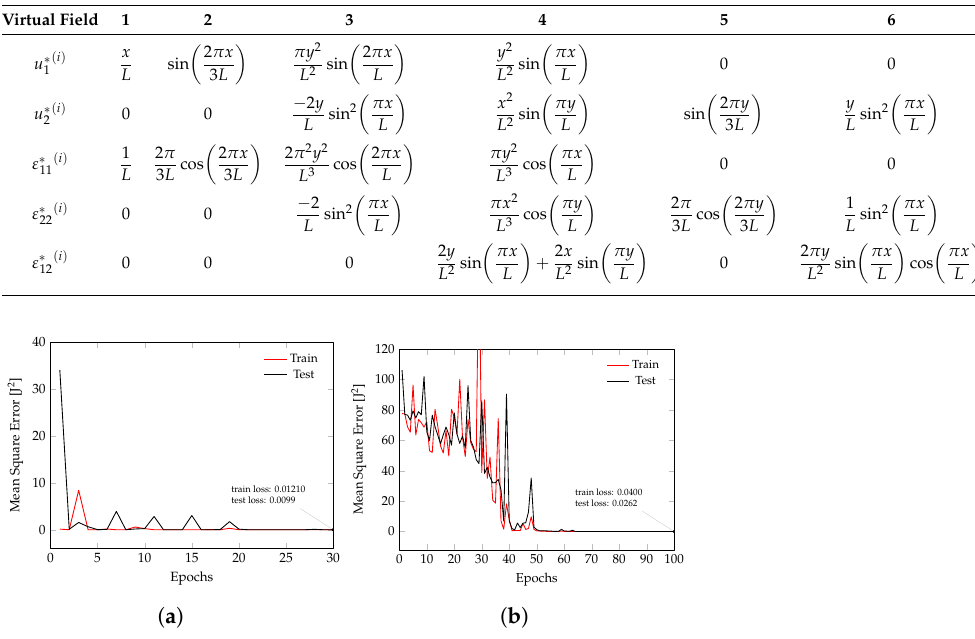
Figure 21. Learning curves for ( a ) the elastic and ( b ) the elasto-plastic response